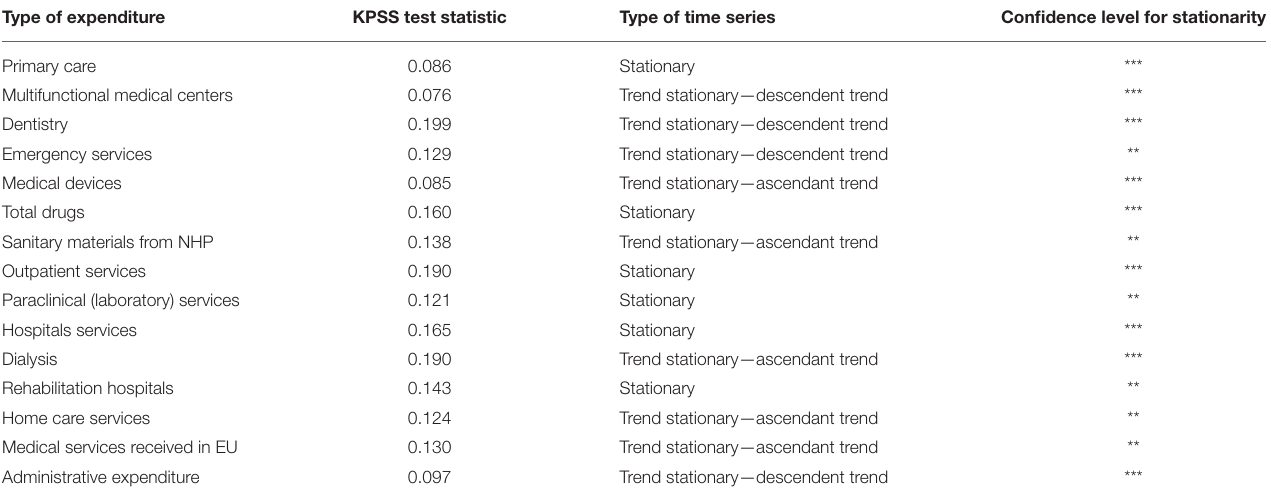
TABLE 2 | KPSS statistics test for the trends in different types of expenditure,